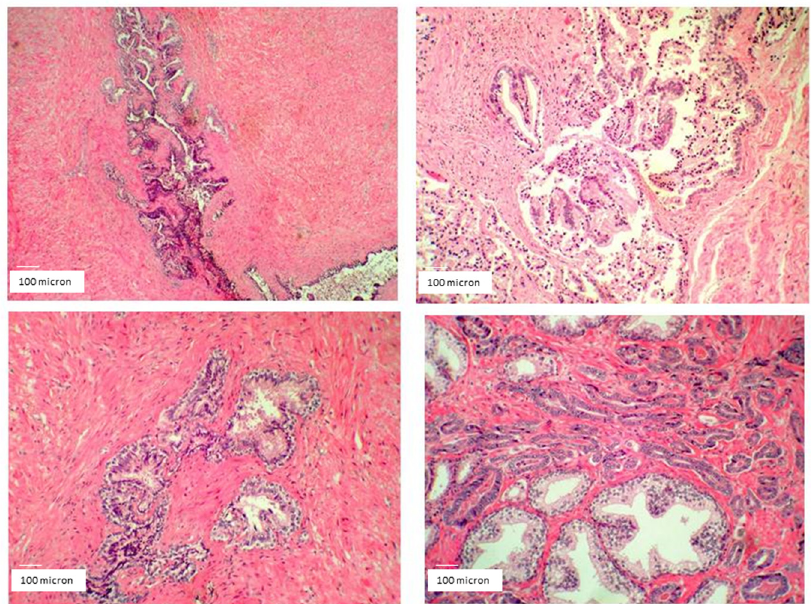
Figure 15. Prostate cancer histopathological analysis detecting poor signs of inflammation in the cancer parenchyma and surrounding tissues despite the high malignancy grade (Gleason 9) after HOO treatment. The presence of tumor-associated macrophages was not detected at all, at variance with the usual aspect of this cancer type (magnification 100 ×